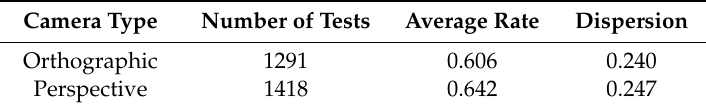
Table A1. Numerical results of the users regarding the camera type.